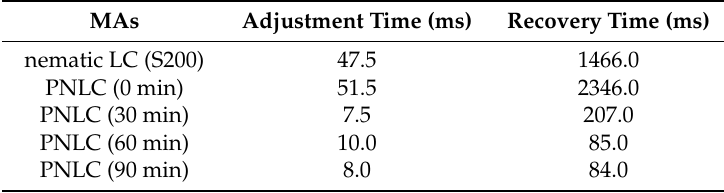
Figure 8. Curves of measured response time of the MAs: ( a ) The MA based on the nematic LC (S200) and ( b ) the MA based on the PNLC with 30 min UV exposure time. Table 1. Results of measured response time of